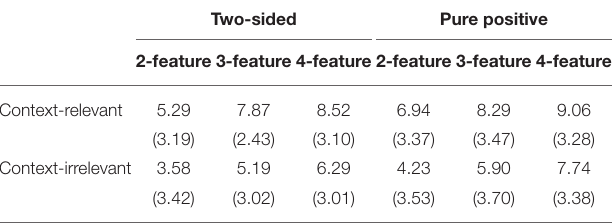
TABLE 3 | (Pilot study) Users’ perceived explanation effectiveness regarding the three content design factors: feature type, contextual relevance, and the number of features (Mean, and SD in the